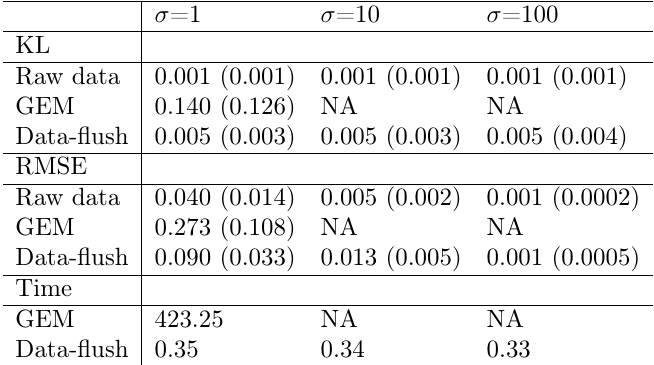
Table 1. Private Poisson regression using raw data, data privatized by data-flush in (2.2), and data privatized by GEM (Liu, Vietri, & Wu, 2021). Kullback-Leibler divergence (KL) and root mean square error (RMSE) for regression coefficients (with the standard error in parenthesis), together with privatization time (Time, in seconds) are presented based on 200 replications. Here the privacy factor ε is 1 , σ is the standard deviation of each covariate before discretization (a step required by GEM), and NA indicates that an algorithm fails to converge within two